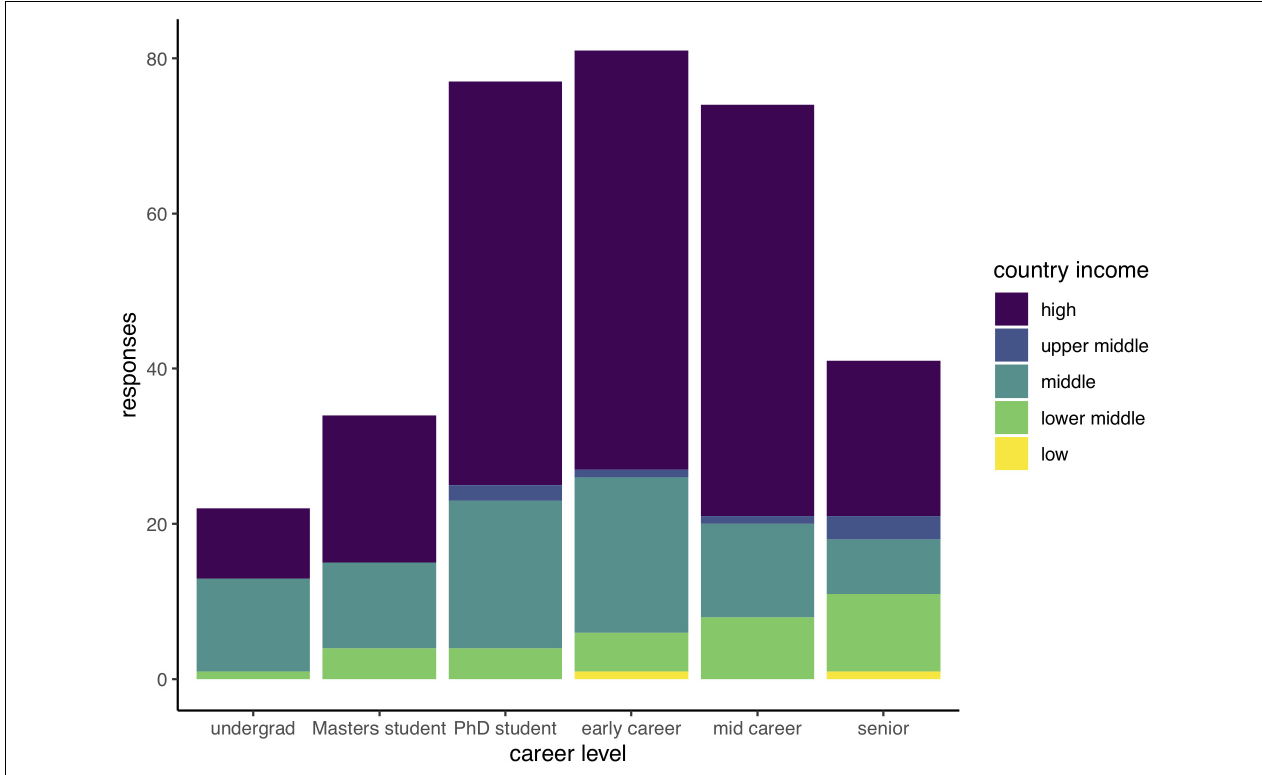
FIGURE 1 | Distribution of survey respondents by career stage and the World Bank definition for the income of the country of residence (World Bank,